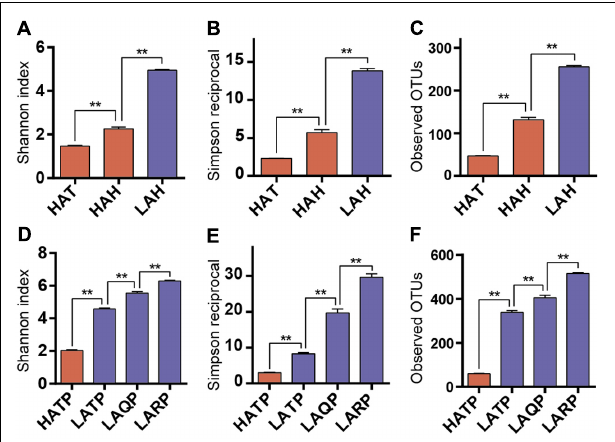
FIGURE 2 | Alpha diversity differences between groups. Three metrics were used for comparison including Shannon index (A,D) , Simpson reciprocal (B,E) , and the number of observed OTUs (C,F) in both humans and pigs. Red and blue bars represent the high- and low-altitude skin groups, respectively. ∗∗ p < 0.01, Mann–Whitney U